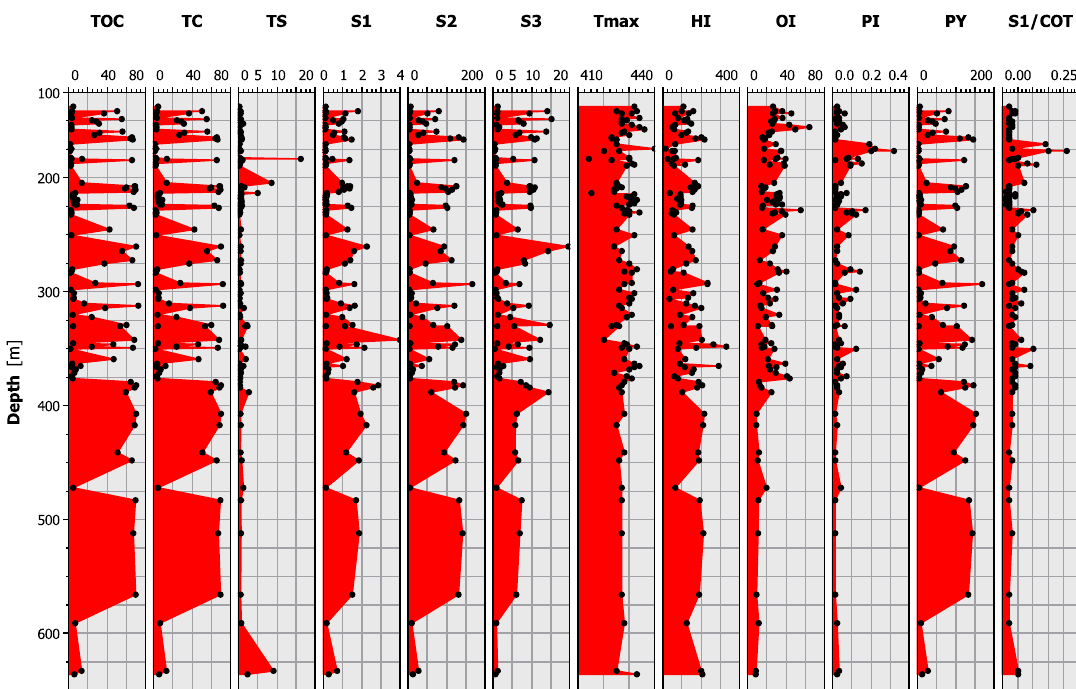
Figure 4. Results of the geochemical analyzes. Total organic carbon (TOC), total carbon (TC), total sulfur (TS), and Rock–Eval pyrolysis of the Cerrejón Formation rocks in the ANH-CARRETALITO-1 Well, see Supplementary Materials Table S1.